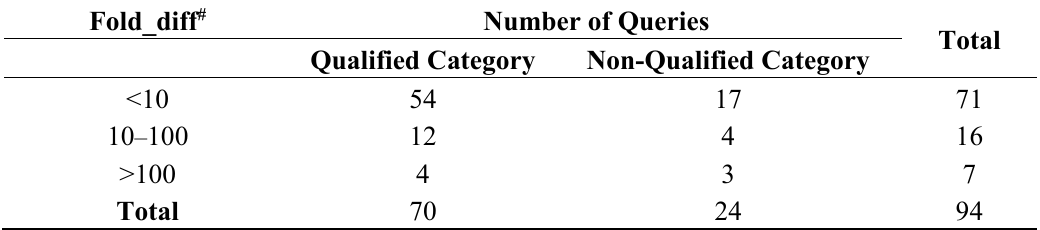
Table 4. Training set queries sorted (in qualified and non-qualified categories) based on its k -NN model-based predicted class, and further divided based upon order of magnitude